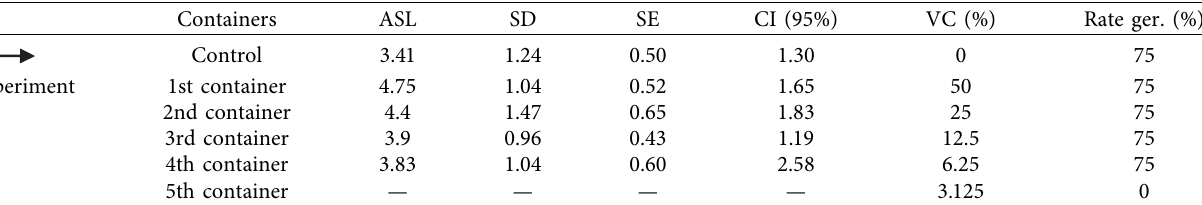
Table 6: The shoot length of a plant at the first week.